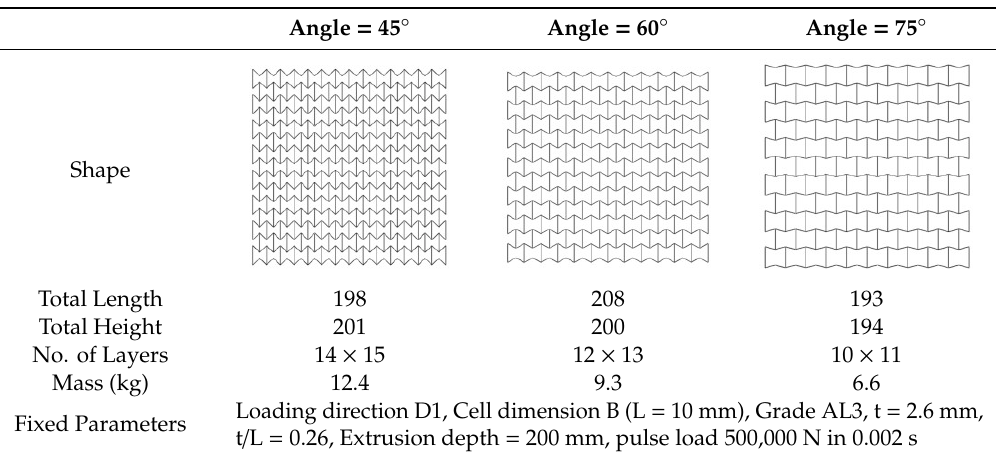
Loading direction D1, Cell dimension B (L = 10 mm), Grade AL3, t = 2.6 Fixed Parameters